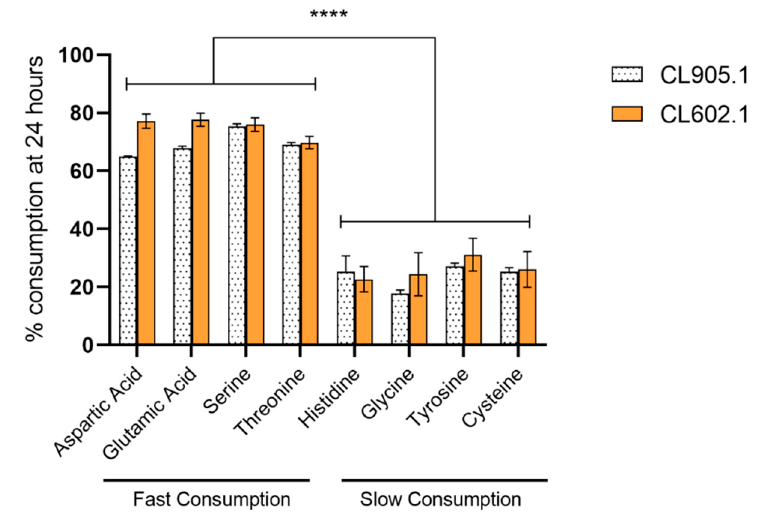
Figure 7. Preferred amino acid consumption in S. eubayanus strains at 24 h. Gray: CL905.1; Orange: CL602.1. (****) depict significant differences between amino acids with a p -value < 0.001, one-way ANOVA.